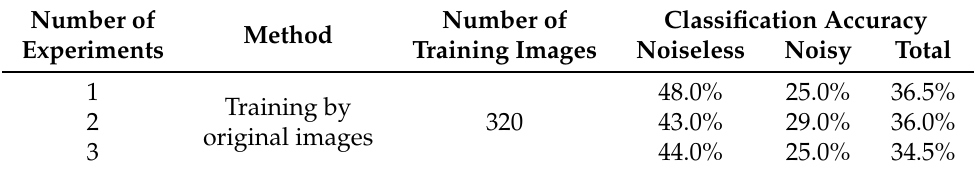
Table 1. Classification accuracy of the network trained using original images.